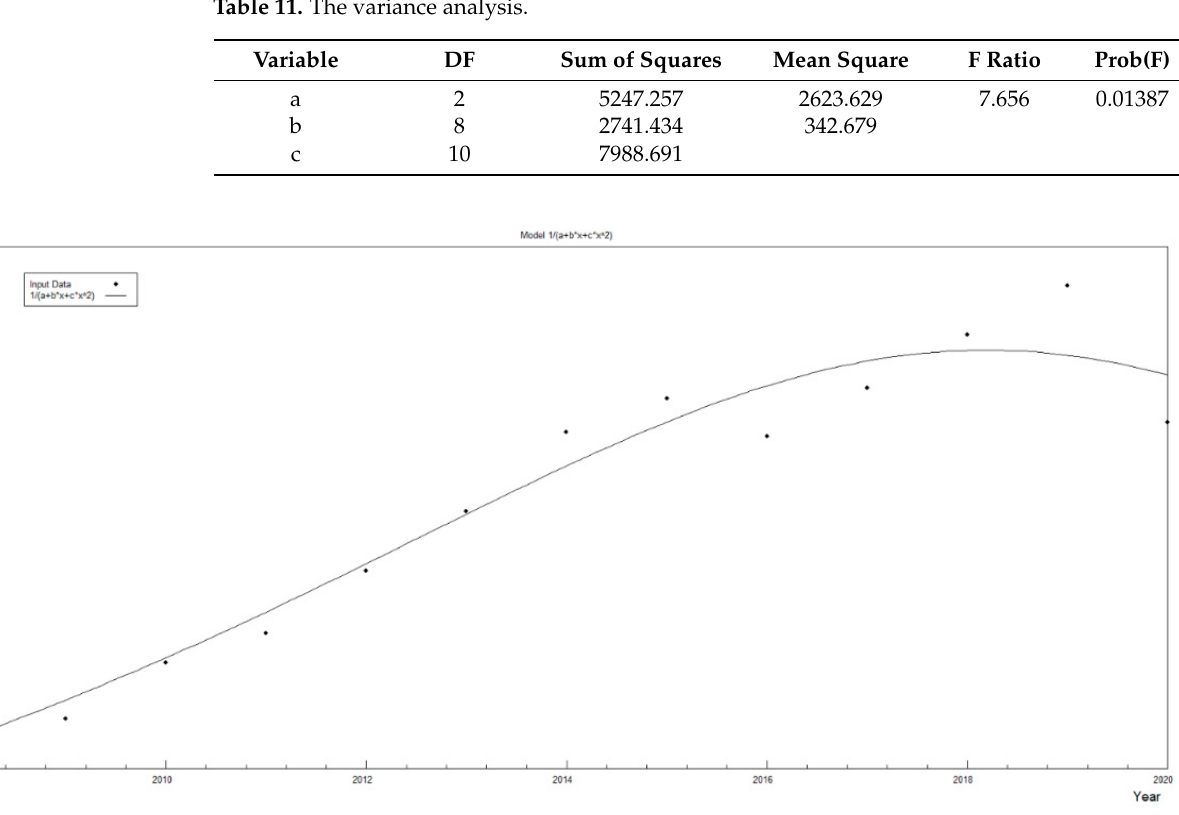
Table 10. Values of the coefficients of the mathematical model for a 99% confidence interval of the function.